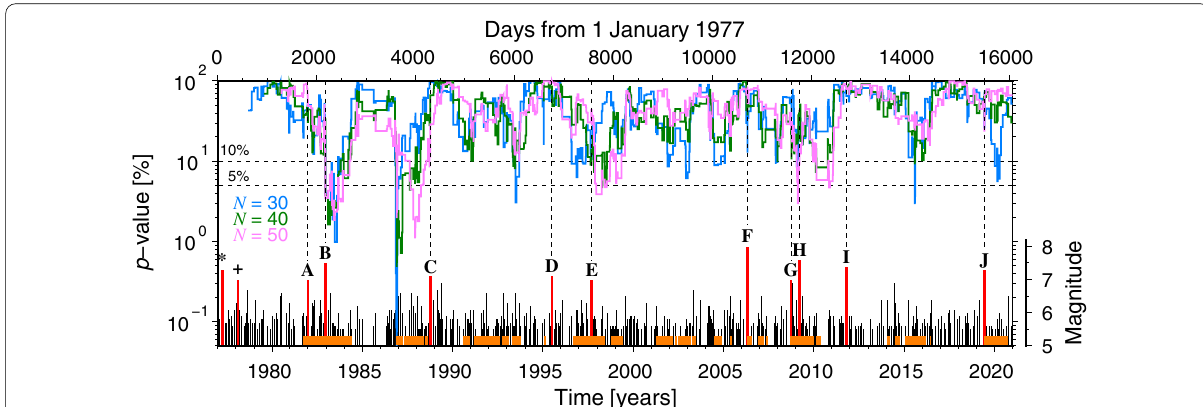
Fig. 2 Temporal variations of the p -value (colored trends at top) and earthquake magnitudes (vertical bars). The p -value trends are plotted for number windows of N 30 (blue), 40 (green), and 50 (purple) events with their ending time shifted by one day. Dashed horizontal lines indicate = p -values of 5% and 10%. Red bars and associated symbols are as in Fig. 1. Orange lines at the bottom indicate alarmed periods corresponding to the red star in Fig.